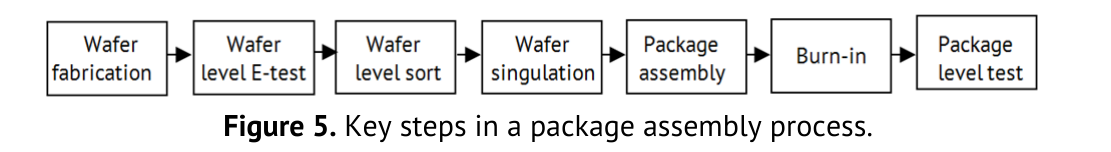
Figure 5. Key steps in a package assembly